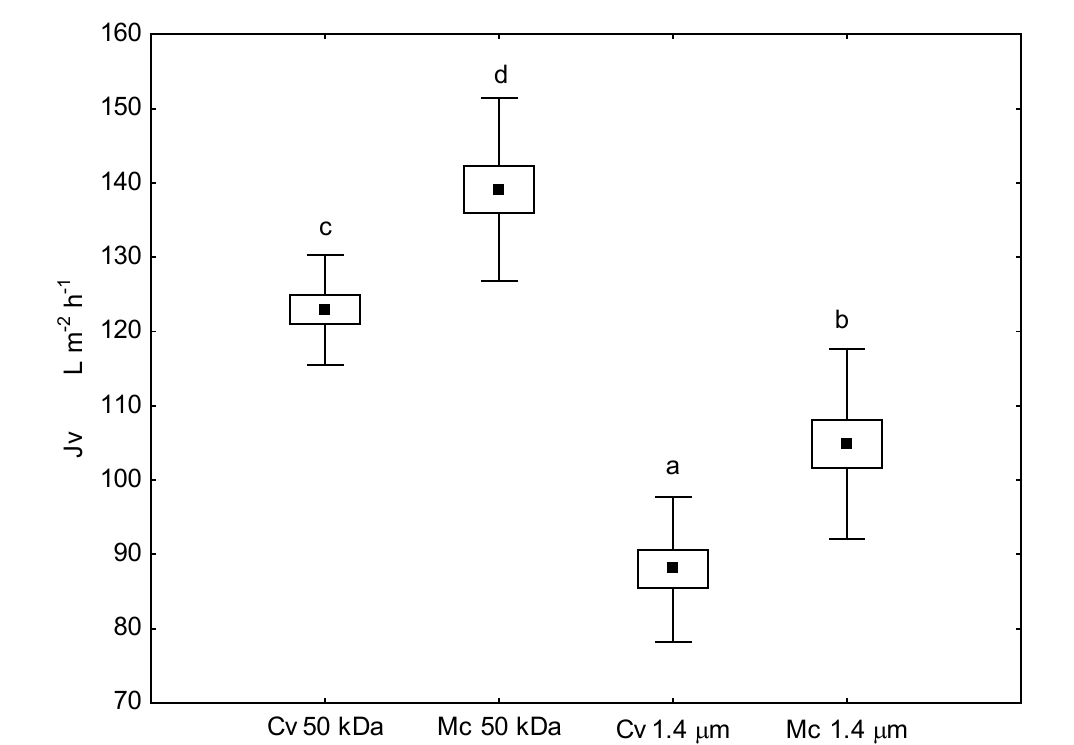
* Steady-state flow from 80 min of filtration.